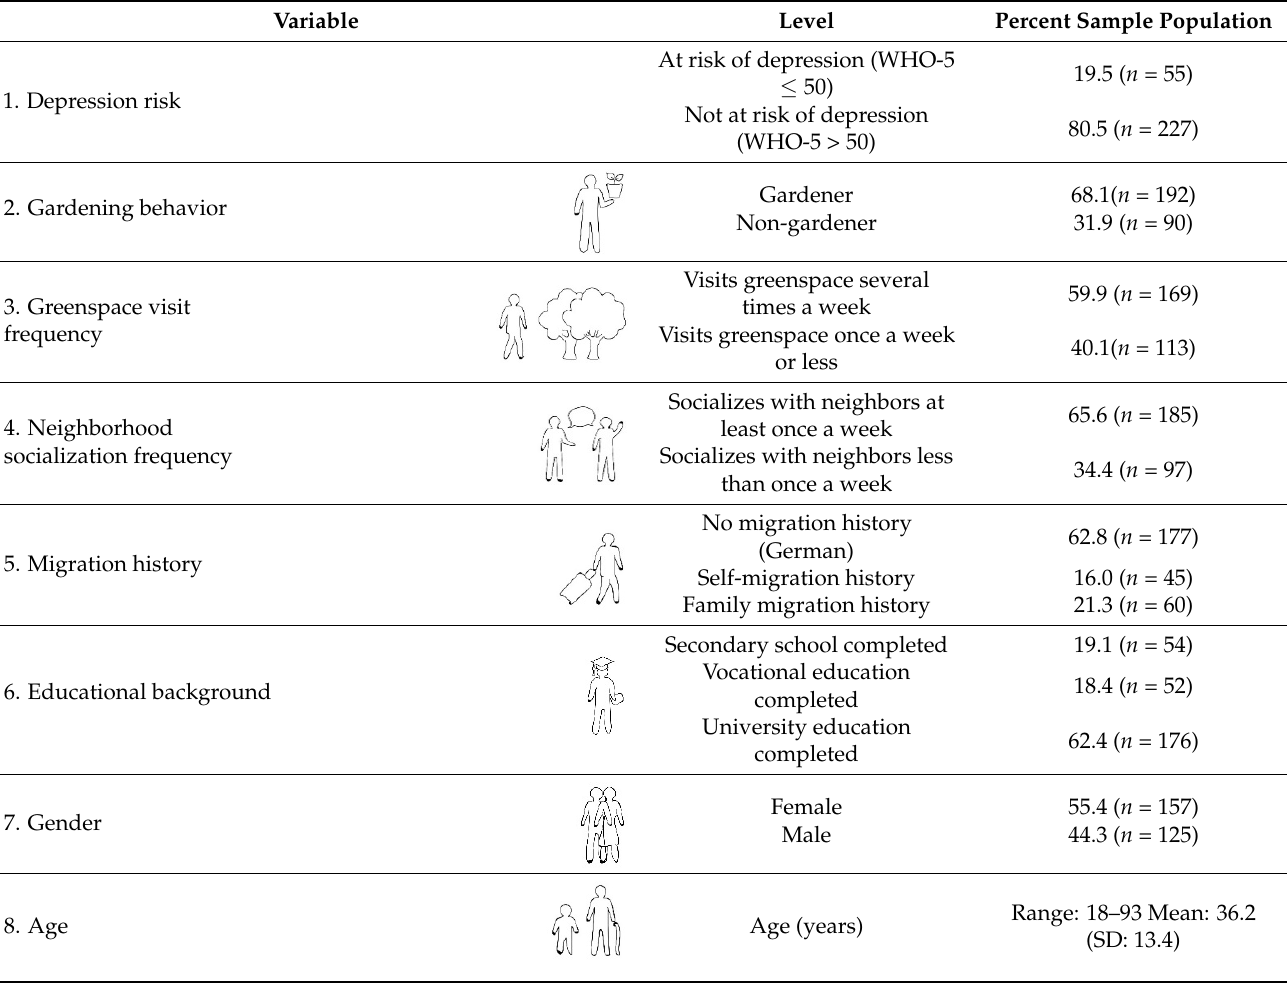
Table 1. Descriptive statistics for the sample population ( n = 282) of variables considered in analyses. All values reported as ‘percentage of the sample population,’ with absolute counts of sample population provided next to the percentage in parentheses, unless otherwise noted. For the derivation of these variables, see Table A1.